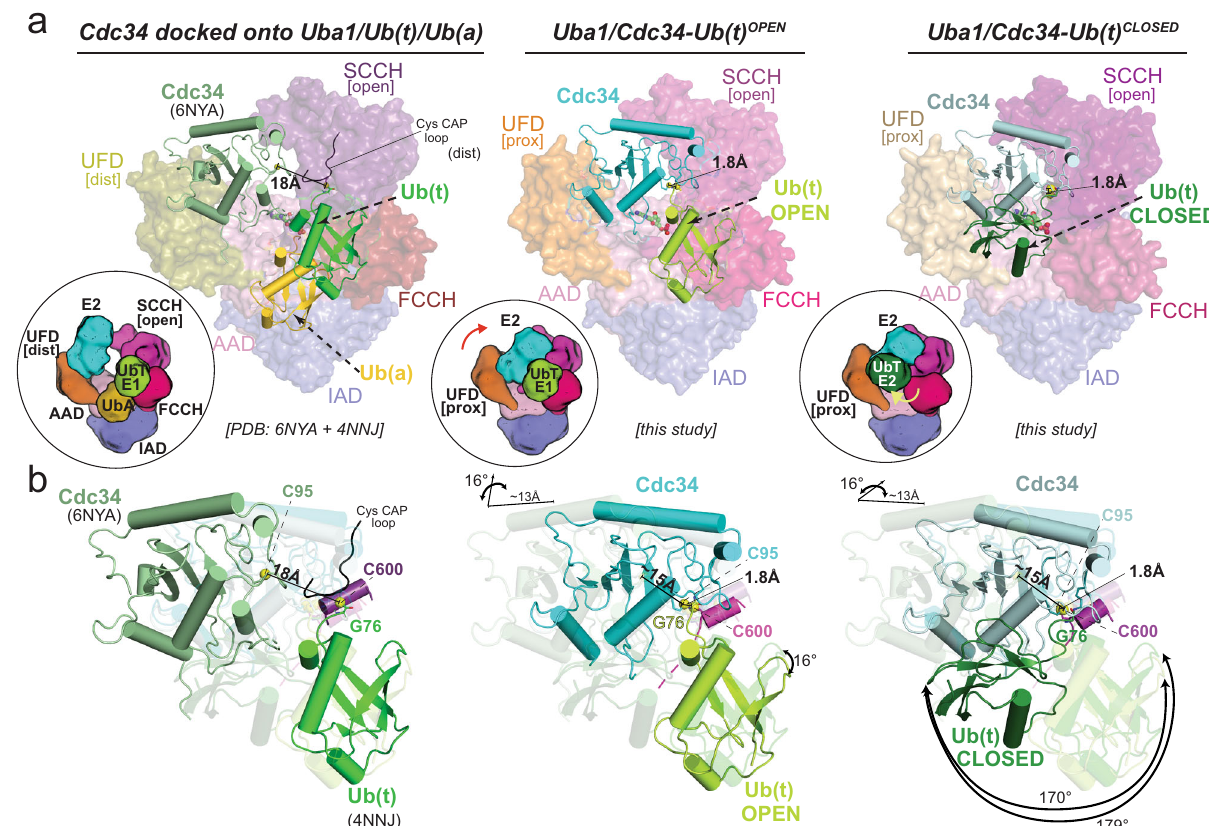
Fig. 5 Conformational changes bring E1, E2, and Ub(t) active sites together. a Left, Cdc34 E1-bound (PDB: 6NYA) modeled onto Uba1 doubly loaded UFD (PDB: 4NNJ) Uba1 in surface representation with domains colored and Cdc34 and Ub in cartoon representation. Sulfur atoms of catalytic cysteines are colored yellow. Middle, Uba1/Cdc34 A141K – Ub(t) OPEN structure with Uba1 in surface representation and Cdc34 and Ub in cartoon representation. Ub(t) OPEN sits on top of Uba1 FCCH domain. Right, Uba1/Cdc34 A141K – Ub(t) CLOSED structure with Uba1 in surface representation and Cdc34 and Ub in cartoon representation. Ub(t) CLOSED binds with E2 Cdc34. b Left, Cdc34 and Ub(t) from the docking model as shown in a Left, distance between E1 Cys and E2 Cys is indicated as line. Middle, Cdc34 and Ub(t) from Uba1/Cdc34 A141K – Ub(t) OPEN structure as shown in a Middle. The relative distance between E2 Cys from docking model and E2 in the open structure is indicated as line. With respect to the docking model, Cdc34 rotates by 16° and translates 13Å, while Ub(t) rotates by 16°. Right, Cdc34 and Ub(t) from Uba1/Cdc34 A141K – Ub(t) CLOSED structure as shown in a Right. Cdc34 rotates by 16° and translates 13Å with respect to the docking model, while Ub(t) rotates by 179° with respect to the docking model and rotates by 170° relative to the Ub(t) OPEN